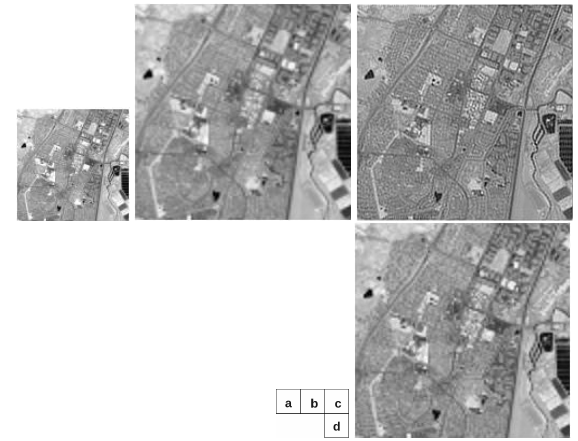
Figure 3: SR results on AVIRIS HS Band 100 for q = 2 (a) LR image of size 100 × 100 , (b) Bicubic interpolation, (c) Iterative backprojection Method, and (d) Proposed